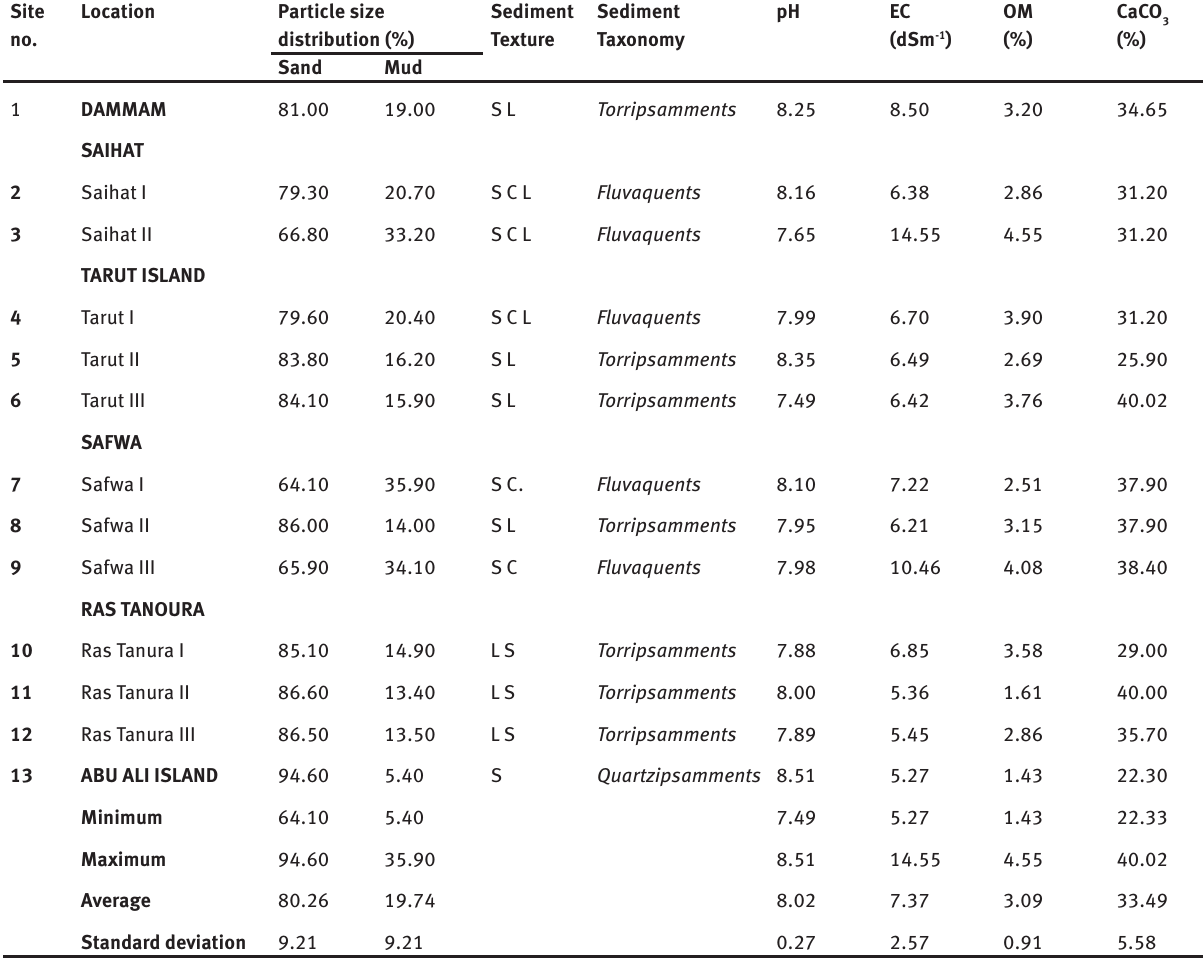
Table 1: Descriptive statistics of physico-geochemical properties of sediments along the west coast of Arabian Gulf, Saudi Arabia. Site no.